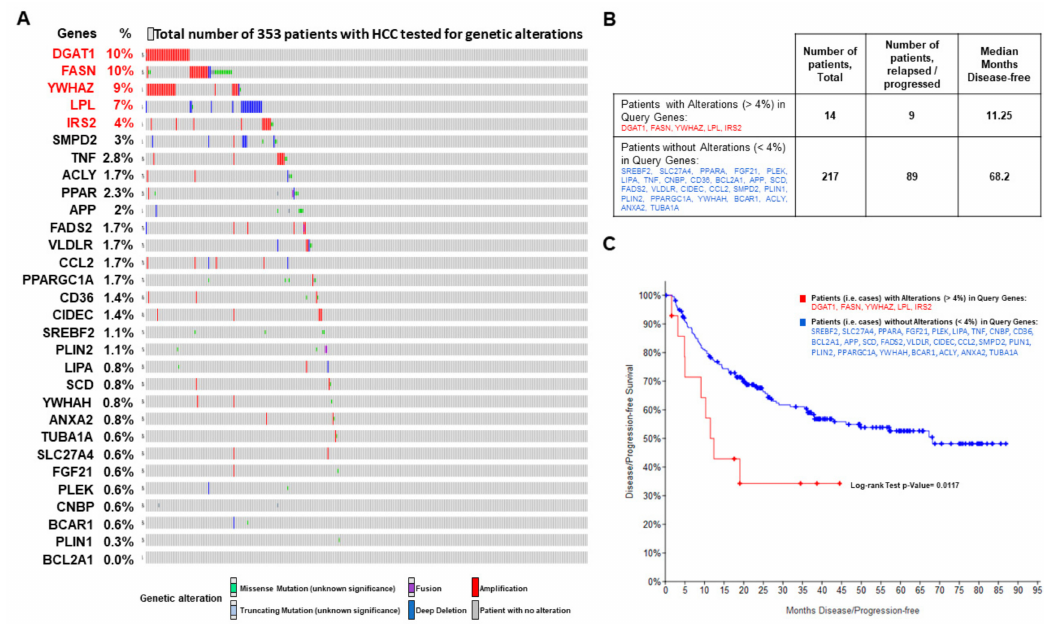
Figure 10. A core of 5 genes involved in NASH progression have alterations found in hepatocellular carcinoma which are associated with a very poor outcome. ( A ) Investigation of the 30 genes involved in NASH on genomic data including copy number variations, single nucleotide polymorphism, mutation, fusion and deletion of liver cancer cohort from TCGA consortium performed in 353 patients (https: // www.cbioportal.org / ) [72] leading to five genes present in more than 4% of patients. ( B ) Table from (A) recording the total patients with genetic alterations ( ≥ 4%) in the 5 genes of interest ( n = 14) and the total patients ( n = 217) without genetic alteration ( < 4%). Among these patients some patients ( n = 9 and n = 89, respectively) have been identified with relapse or progression of the liver cancer. ( C ) Kaplan-Meier survival curve between patients ( n = 9) with genetic alterations ( ≥ 4%) in the five genes identified in (A) and patients ( n = 89) without ( < 4%) genetic alterations in the 24 other genes associated with relapsed or progressed cancer. Kaplan-Meier curves were analyzed by log-rank